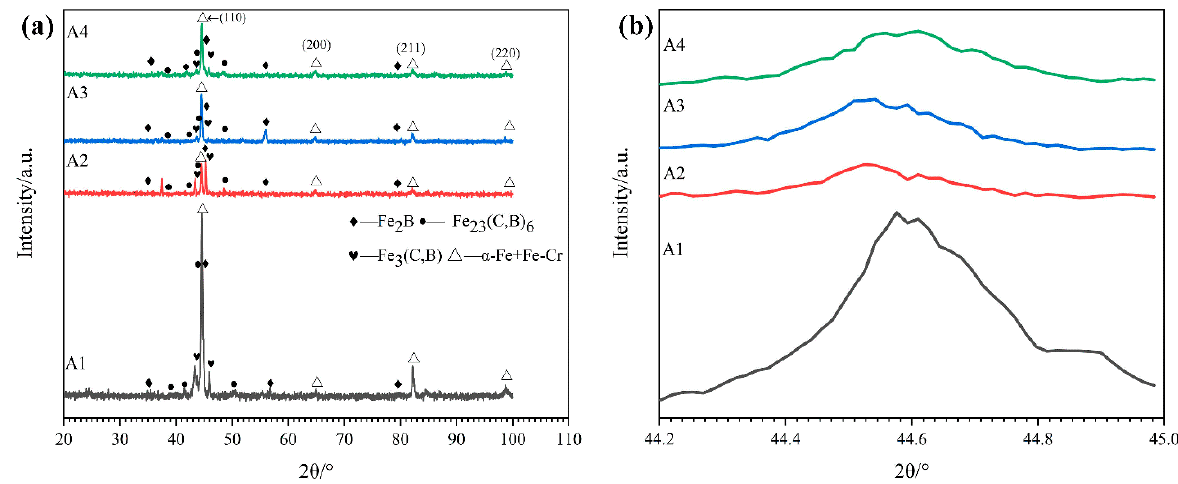
Figure 2. XRD patterns of the as-cast high-boron high-speed steel: ( a ) XRD pattern, ( b ) local peaks of Fe (110).